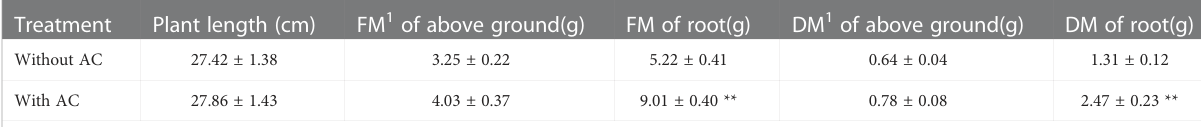
TABLE 1 Growth of P. notoginseng either with or without AC addition in hydroponics.